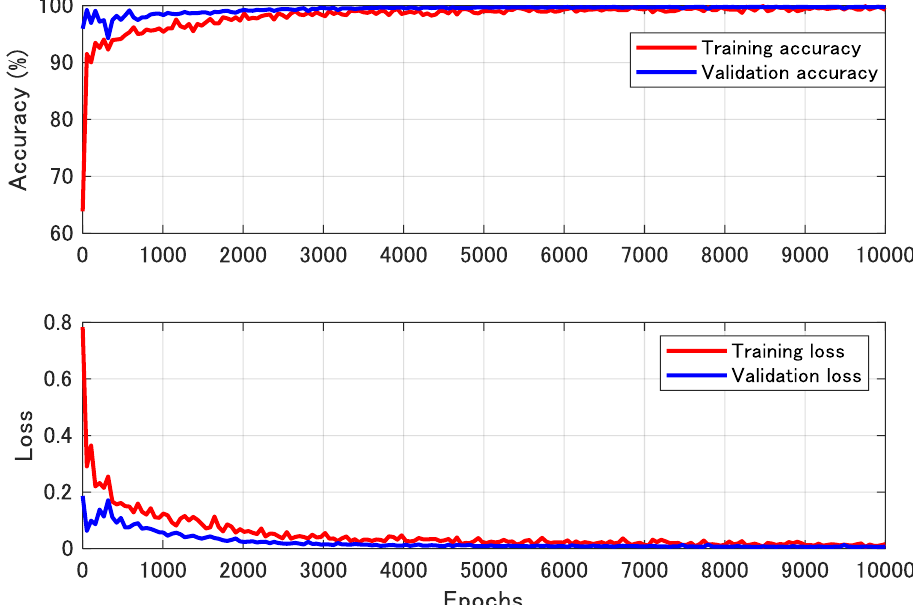
Figure 13. Learning curve of NN. The upper figure shows the training and validation accuracy and lower figure shows the